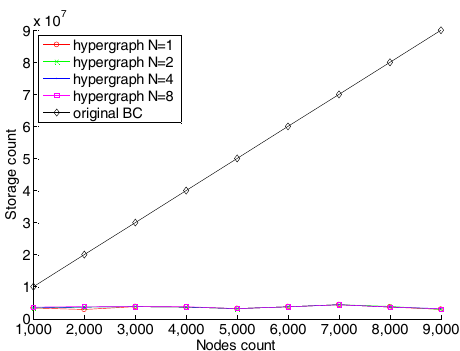
Figure 9. Memory comparison of proposed model with original blockchain model.